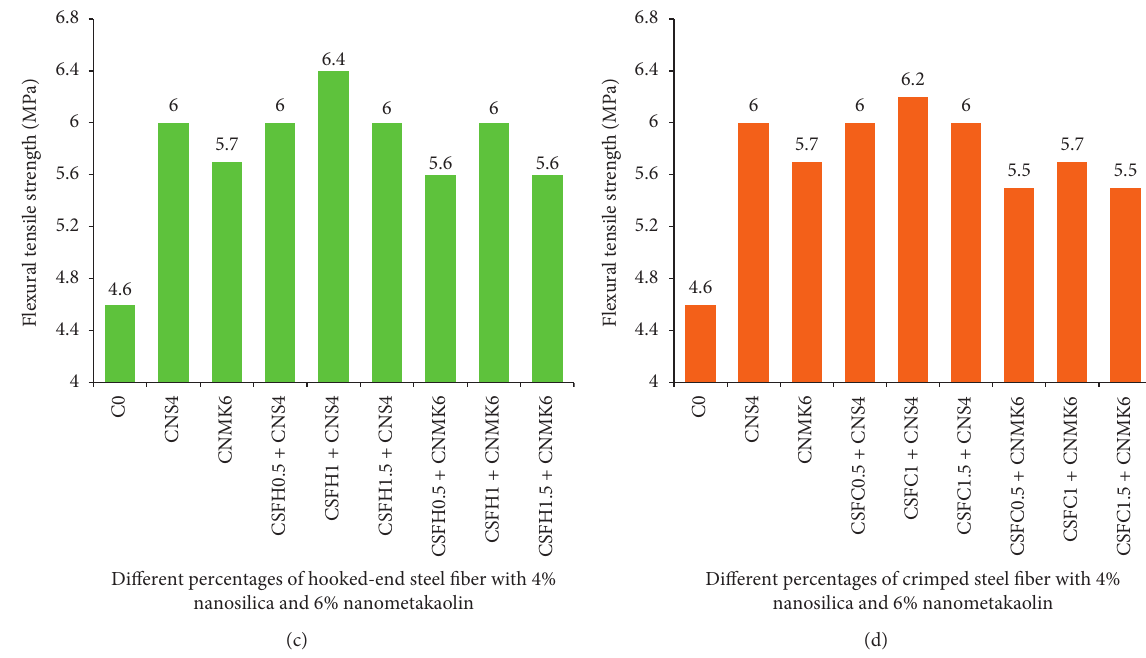
Figure 9: Flexural strength for (a) GPC containing nanosilica, (b) GPC containing nanometakaolin, (c) different % of hooked-end steel fiber reinforced GPC containing 4% nanosilica, and (d) different % of hooked-end steel fiber reinforced GPC containing 6%